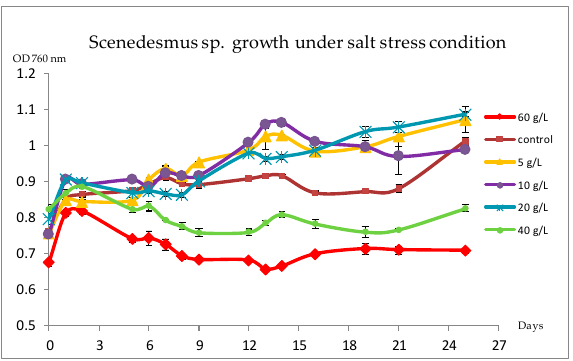
Figure 1. Growth monitoring of Scenedesmus sp. cultured in Modified Detmer’s Medium (MDM) (control) and in MDM medium supplemented with 5, 10, 20, 40, and 60 g/L of NaCl, by the measure of the optical density (OD) at 760 nm. Biomolecules 2020 , 10 , x